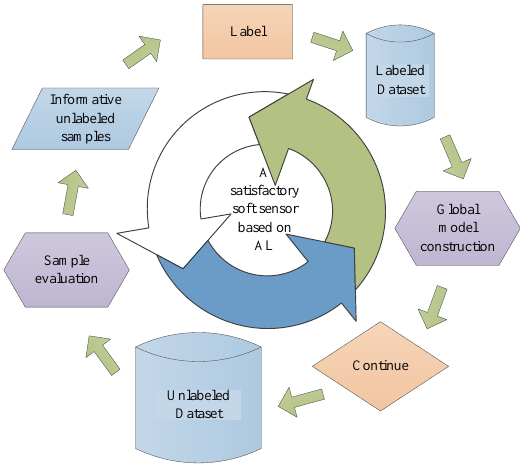
Figure 1. Flow diagram of active learning (AL) based soft sensor model l ing process.